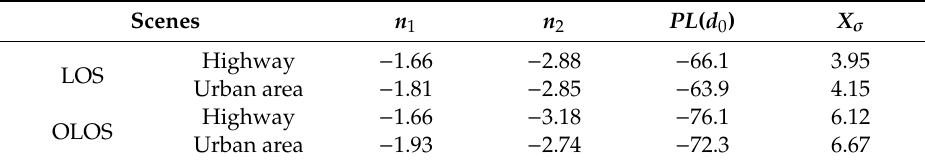
Table 1. Wireless network attenuation model